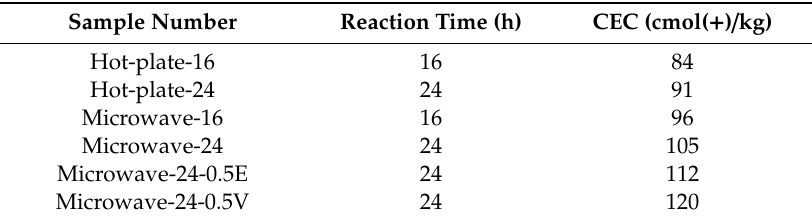
Table 2. Cation exchange capacity (CEC) of Zn-saponite synthesized using various methods.